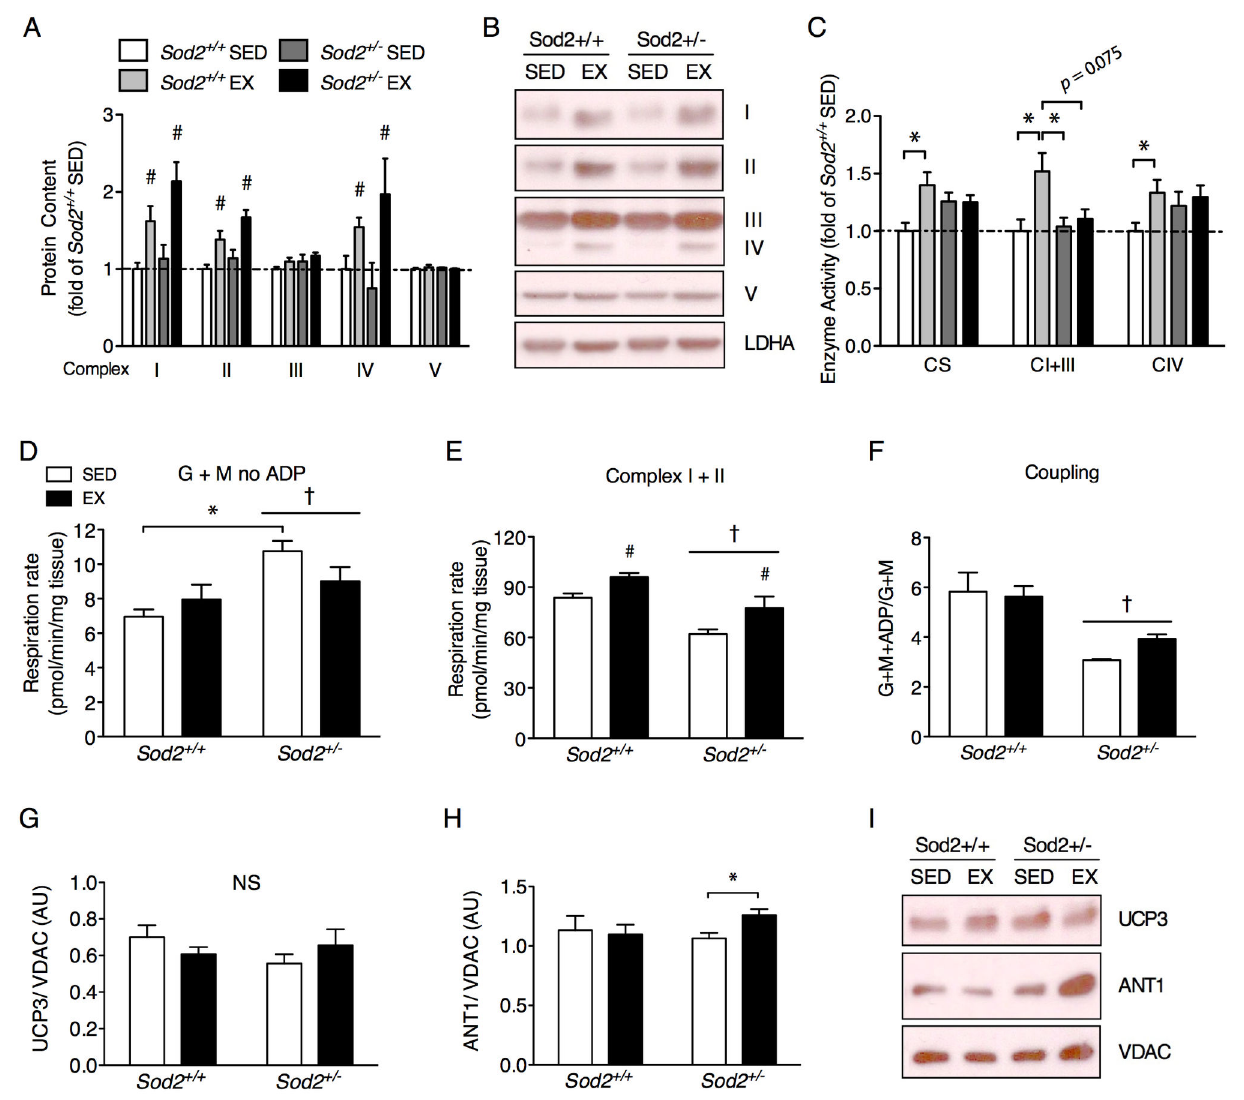
Figure 2. Mitochondrial function is compromised with exercise training in Sod2 +/- mice without influencing organelle biogenesis. Total protein lysates of tibialis anterior muscle were probed by immunoblotting for individual complex subunits (I: NDUFB8, II: SDHB, III: UQCRC2, IV: COXI, V: ATP5A) or assayed for enzyme activity. (A) The protein expression of mitochondrial proteins determined by densitometry relative to LDHA, (B) representative immunoblots of mitochondrial proteins and (C) enzyme activities of citrate synthase (CS), complex I+III, and complex IV (CIV) per unit of protein ( n = 8-10). Data are expressed relative to the Sod2 +/+ SED group. Mitochondrial respiration rates in saponin permeabilized muscle fibers from quadriceps femoris muscle using (D) glutamate and malate without adenylates to indicate a respiratory leak state, (E) glutamate, malate, succinate and ADP to measure maximal coupled oxidative phosphorylation capacity and (F) respiratory coupling ratio of ADP stimulated and non- stimulated respiration using glutamate and malate as substrates ( n = 4-5). (G) UCP3 and (H) ANT1 protein expression in isolated mitochondrial lysates from quadriceps femoris muscle relative to VDAC and (I) representative immunoblots for each group ( n = 8-10). All data are mean±SE. *Indicates a significant difference ( p < 0.05) from the indicated group as determined by 2-way ANOVA. # Indicates a main effect of exercise training ( p < 0.05). † Indicates a main effect of genotype ( p < 0.05). NS, non-significant.